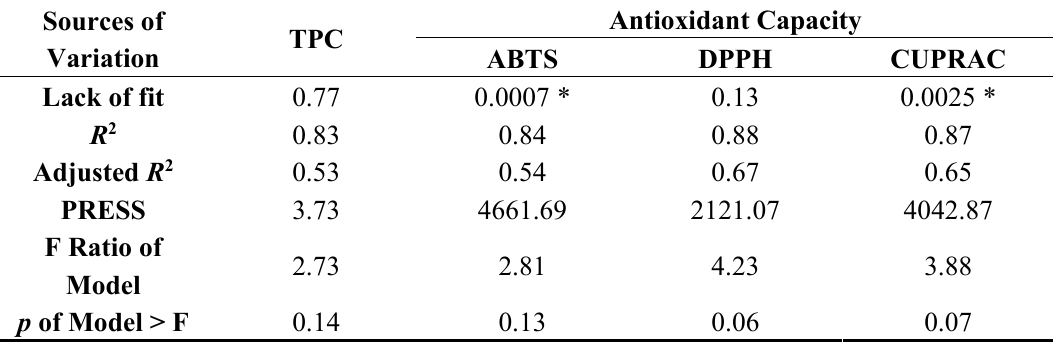
Table 2. Analysis of variance for determination of model